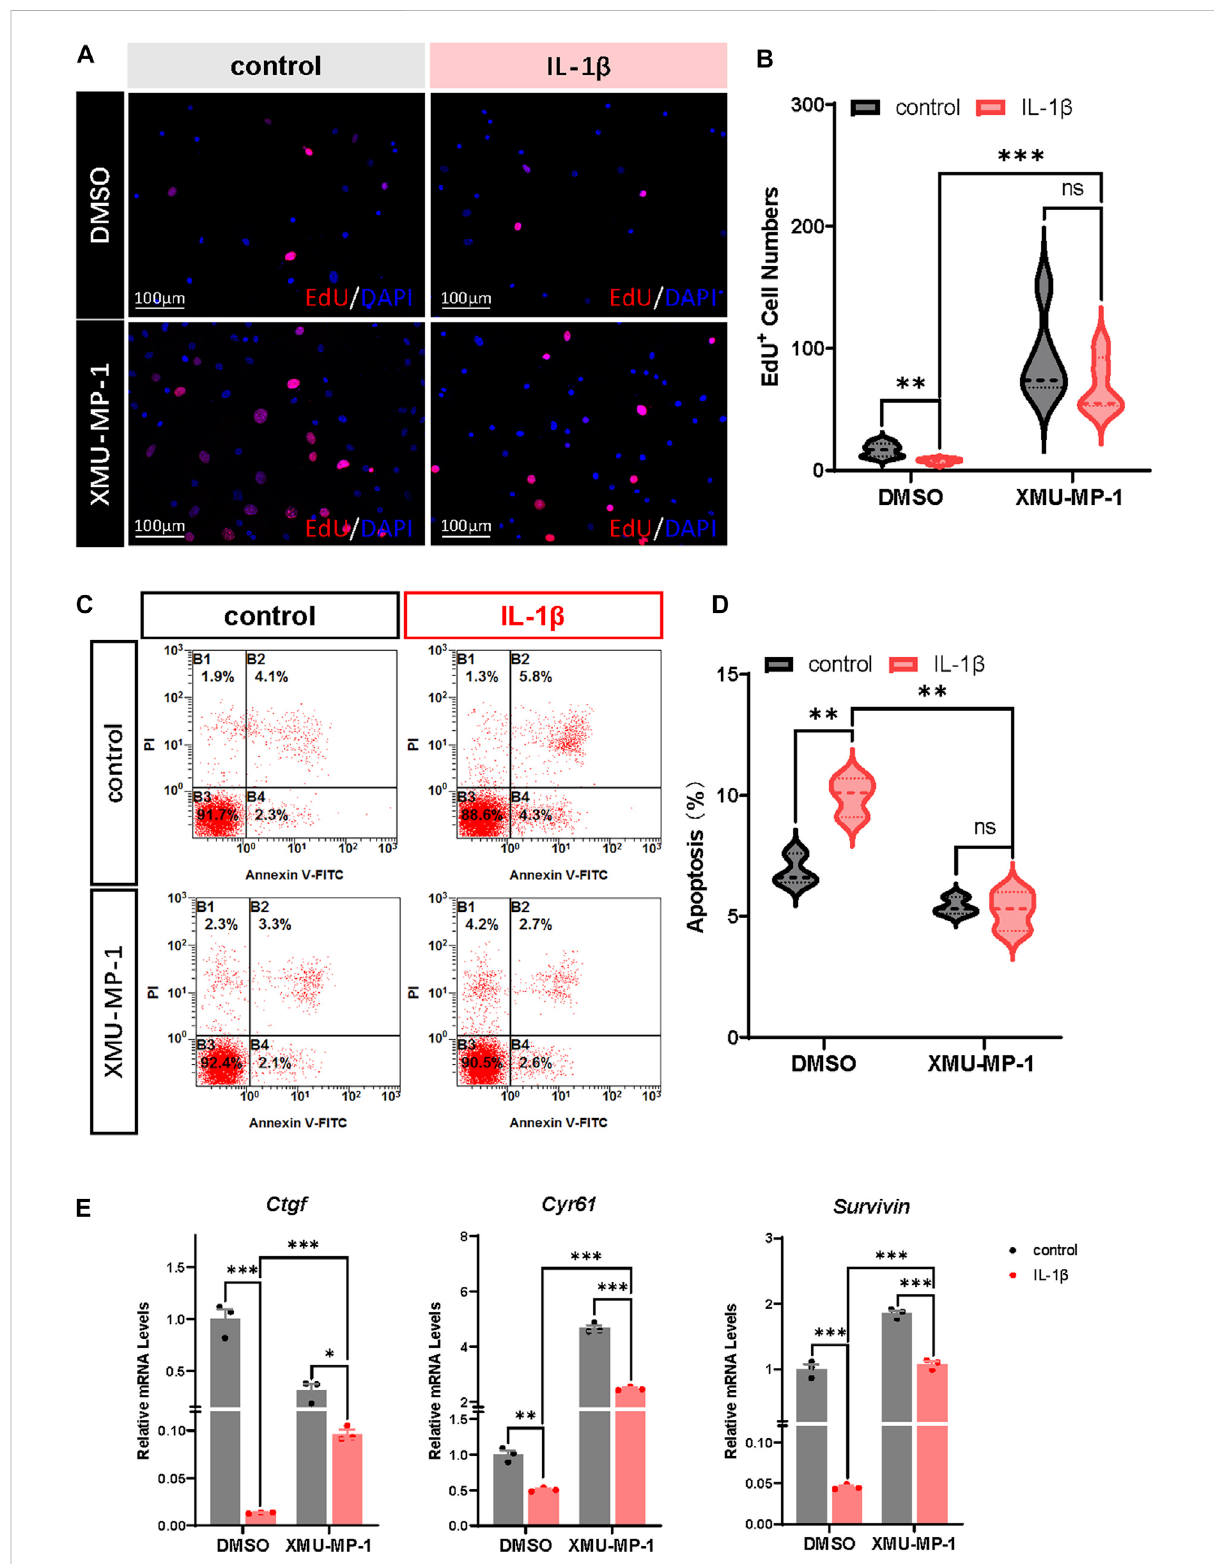
FIGURE 3 XMU-MP-1 facilitates proliferation and suppresses apoptosis of OA chondrocytes. (A) Representative images of EdU labeling chondrocytes treated with IL-1 β or/and XMU-MP-1 for 48 h. EdU (5-ethynyl-2 ′ -deoxyuridine) was added during cell culture and subsequently stained with a fl uorescentdye(red)andDAPI(nuclei,blue). (B) StatisticalanalysisoftheEdU + chondrocytesnumbersinB. (C) Representative fl owcytometrygraphs of cultured primary chondrocytes stained with Annexin V-FITC and propidium iodide (PI) treated with IL-1 β or/and XMU-MP-1 for 48 h. (D) StatisticalanalysisofapoptoticcellsinB. (E) RelativemRNAlevelsofYAPtargetgenes Ctgf , Cyr61 ,and Survivin inchondrocytestreatedwithIL-1 β or/ and XMU-MP-1 for 48 h. All data are presented as mean ± SEM. ns p > 0.05, * p < 0.05, ** p < 0.01, *** p <